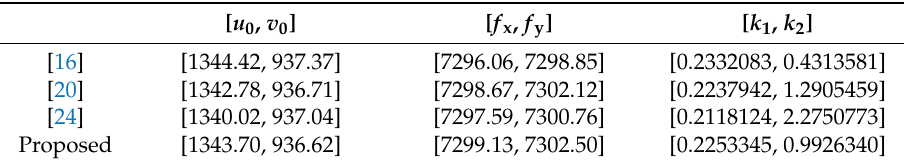
Table 2. Calibration result for four different approaches. k 1 and k 2 denote the 1st and 2nd order radial distortion coefficients.